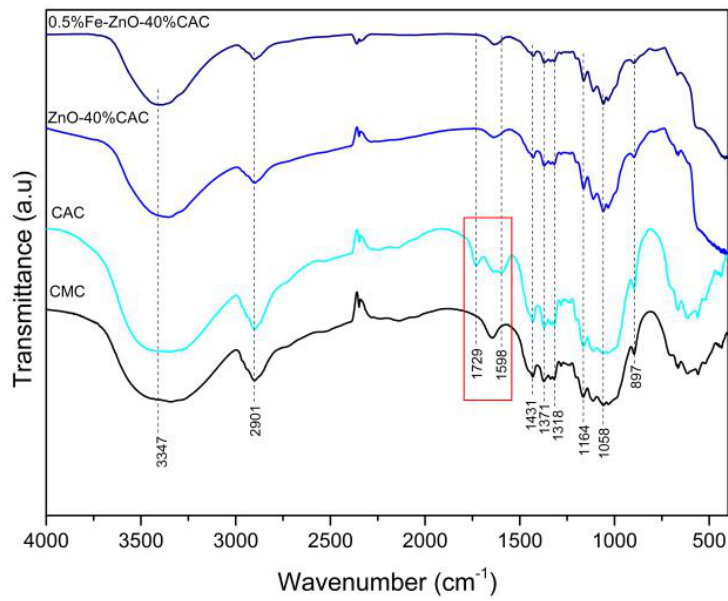
Figure 2. FTIR spectra of CMC, CAC, ZnO-40%CAC and 0.5%Fe-ZnO-40%CAC.